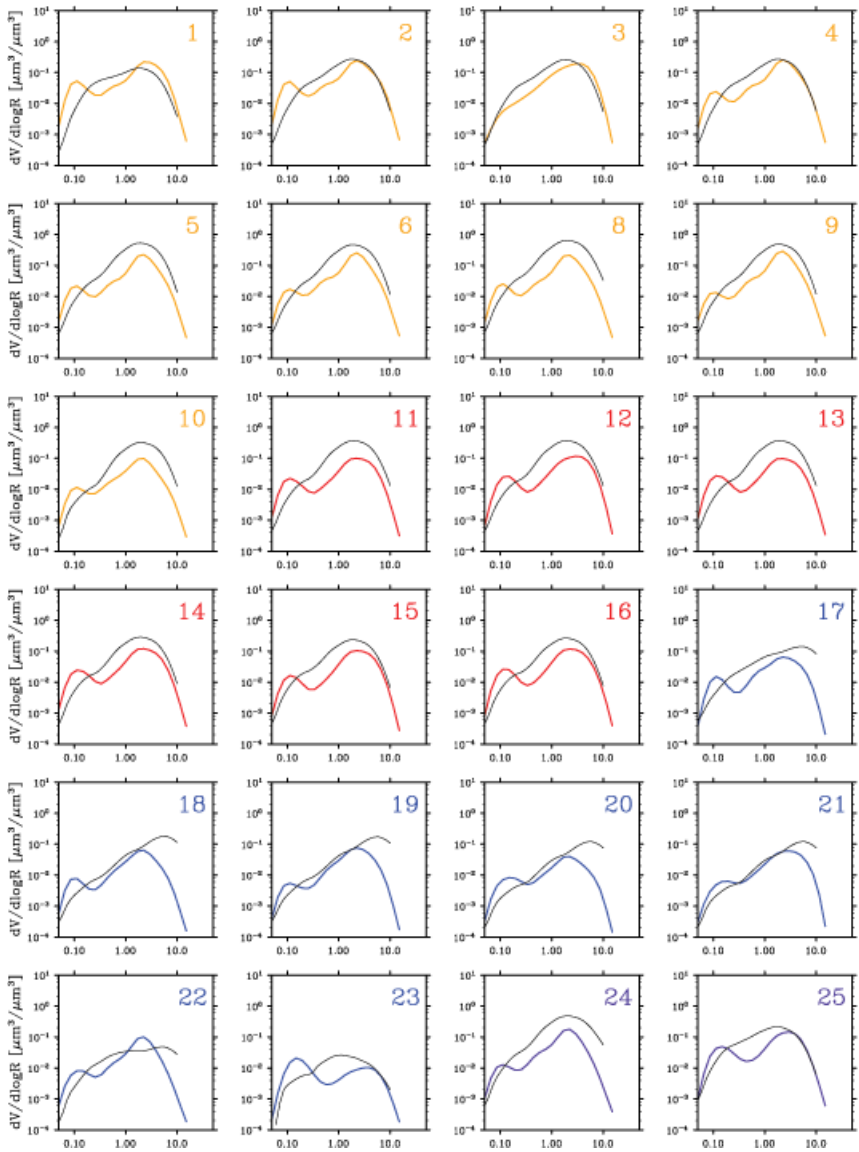
Fig. 5. Comparison of aerosol volume-size distribution at “dusty” sites. Color curves are from AERONET inversion retrieval data. Black curves are results from the climate run of CanAM4-PAM at each site. Color and number are corresponding to the regional groups as in Fig. 4: Middle East (red), Africa (orange), Caribbean-America (blue) and elsewhere in the world (purple). Names and locations of sites are listed in Table 4. Site 7 is not shown because of the lack of inversion retrieval in this location. The abscissa corresponds to the aerosol particle radius in